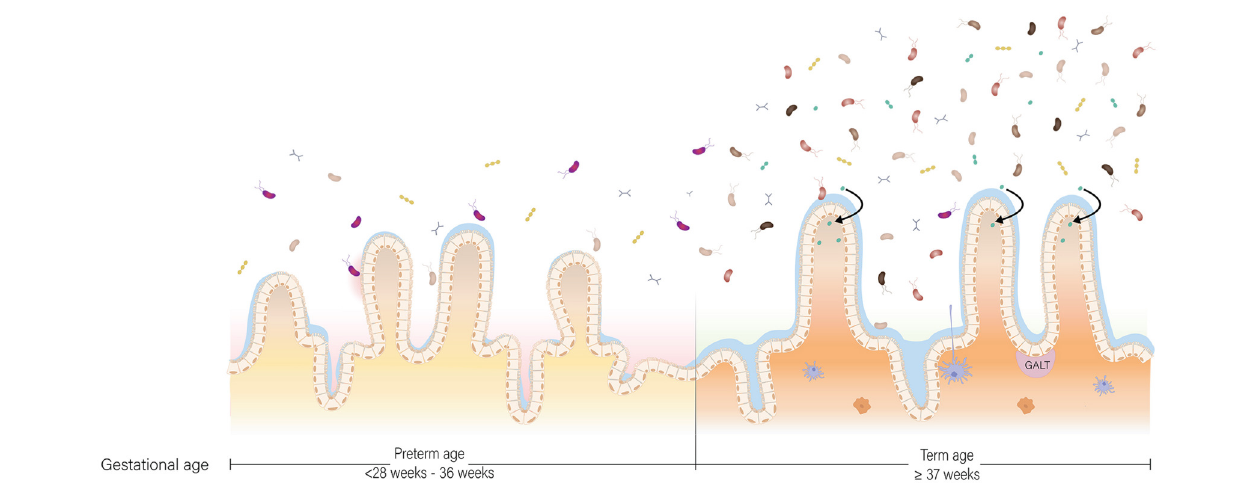
FIGURE 2 | The preterm and term situation of the intestine in early life. In the intestine of infants, maturation of the gut microbiota, gastrointestinal tract and immune system occur at the same time. In the preterm situation, the gut microbiota is low in abundance and in diversity due to the unique set of environmental conditions the infant is exposed to. In the term situation, the gut microbiota is higher in abundance and diversity, and more oriented toward breast milk digestion. The gastrointestinal tract is more mature in term infants compared to preterm infants with regard to enzyme production and activity, nutrient absorption and intestinal motility. Lastly, the preterm situation is characterized by a pro-inflammatory state partly due to a discrepancy in cross-talk between the gut microbiota and immune system, while in the term situation there is oral